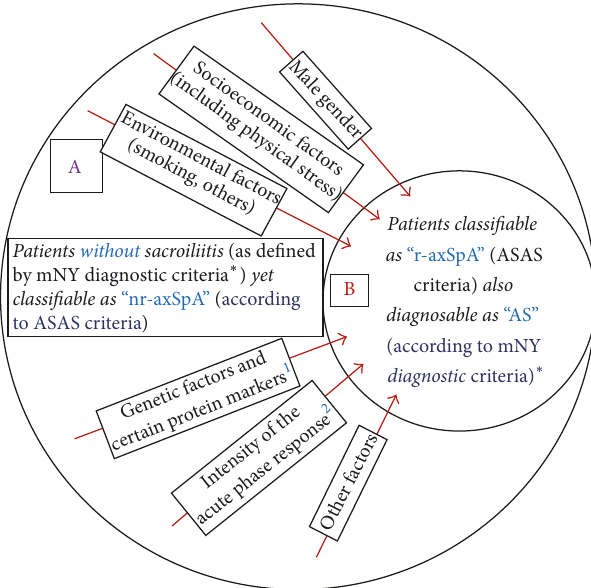
Figure 3: “nr-axSpA” = nonradiographic axial spondyloarthritis; “r-axSpA” = radiographic axial spondyloarthritis; ASAS = Assess- ment of SpondyloArthritis International Society; mNY diagnostic criteria = modified New York diagnostic criteria; “AS” = ankylosing spondylitis. mNY = modified New York, ASAS = Assessment of SpondyloArthritis International Society classification criteria; r- axSpA = radiographic axial spondyloarthritis; AS = ankylosing spondylitis. ∗ It is to be noted that mNY are diagnostic criteria [10]. 1 Genetic factors include HLA B27, ERAP-1, and IL23R and certain protein biomarkers include KIR3DL1, Sclerostin, and Dkk- 1. 2 Intensity of acute phase response is genetically determined, for example, C-reactive protein